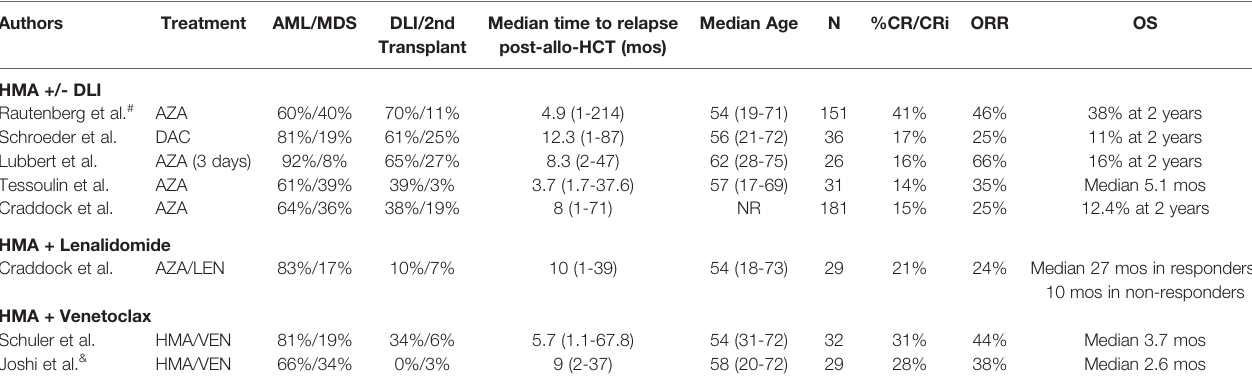
TABLE 2 | Studies using lower-intensity, HMA-based regimens for Post-Allo-HCT